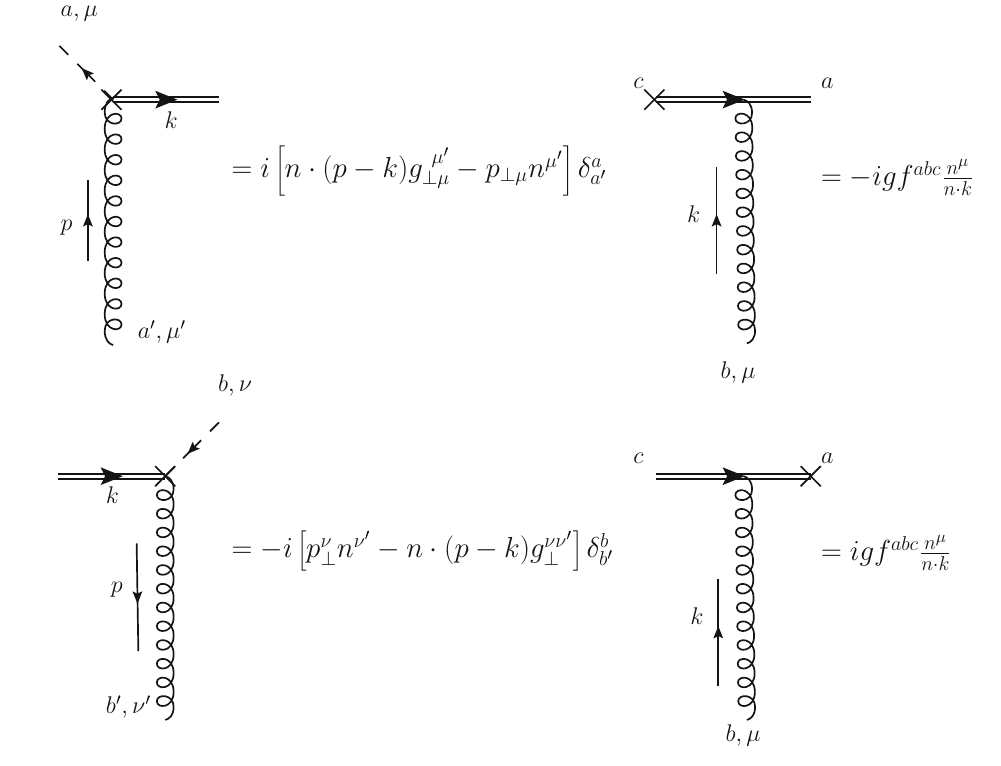
Fig. 1 Feynman rules for quasi gluon distribution